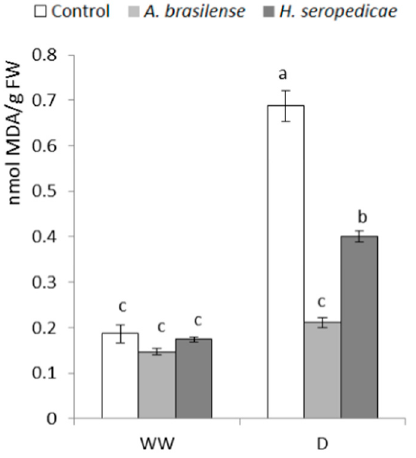
Figure 8. Malondialdehyde (MDA) concentration 20 DAS. Data are shown as means ± SD ( n = 24). Means with common letters are not significantly different ( p > 0.05). The plants were cultivated under WW or D conditions. The inoculation * drought interaction p < 0.0001.